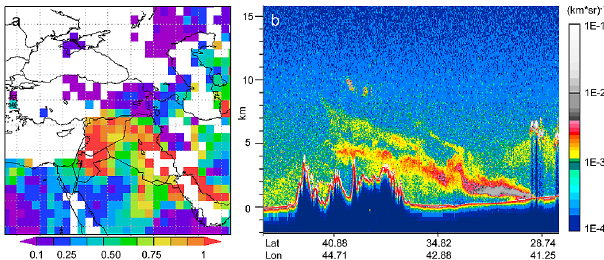
Fig. 7. (a) MODIS AOD values for 18 May 2011 and (b) CALIOP/CALIPSO transact showing attenuated backscatter coeffi- cient (km − 1 sr − 1 ) profiles at 532nm with 60m vertical and 12km horizontal resolution. The outline of the topography is shown as a solid orange line. Thick clouds appear in white and dust clouds in orange-red. Position of the transact is shown in Fig.